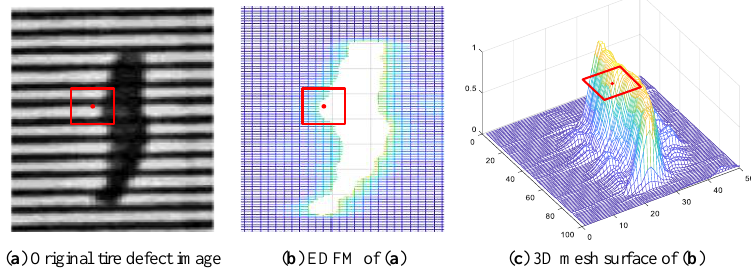
Figure 8. Exhibition of difference between defect image and DFM.